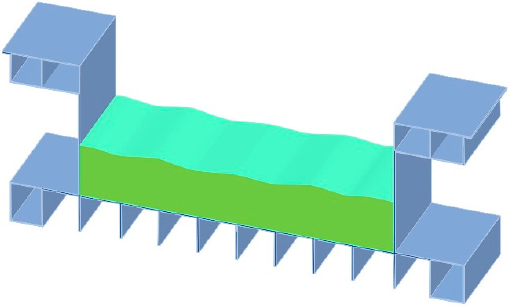
Figure 7. The origin of coordinates is set in the middle of the floor of the water channel.